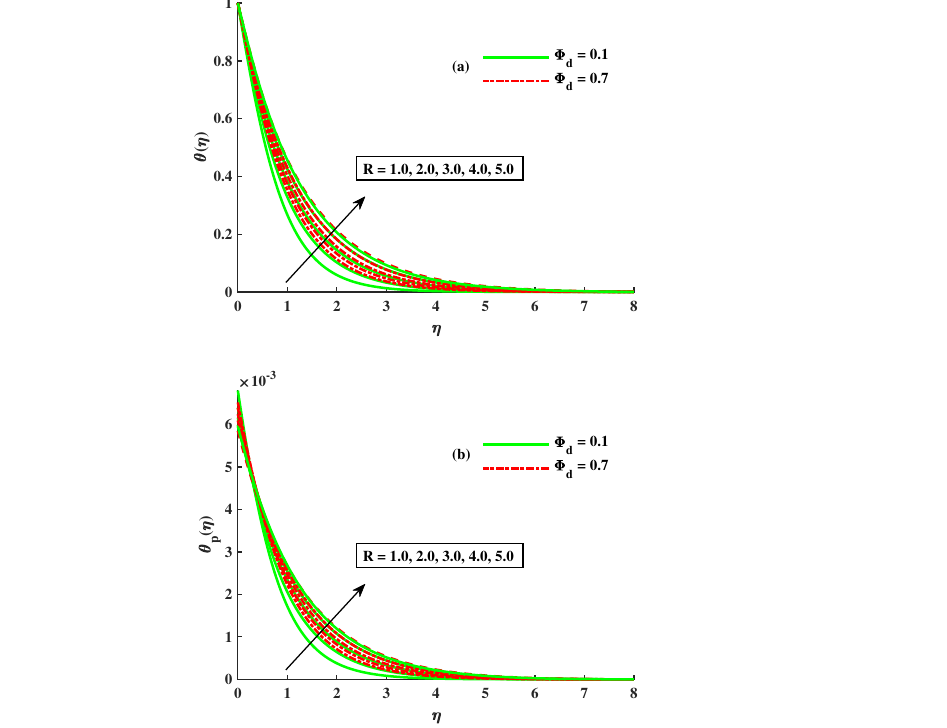
Figure 7. Influence of φ d & λ on ( a ) H (cid:48)